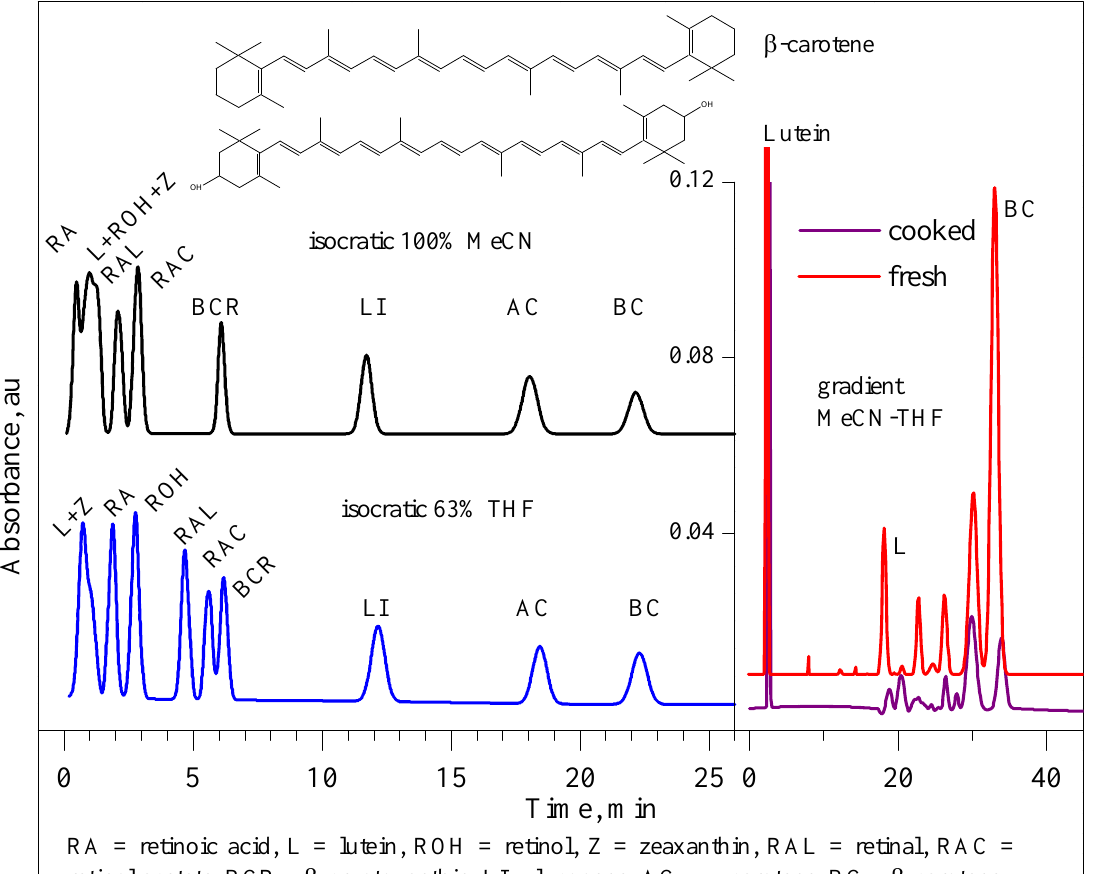
RA = retinoic acid, L = lutein, ROH = retinol, Z = zeaxanthin, RAL = retinal, RAC = retinol acetate, BCR = β -cryptoxanthin, LI = lycopene, AC = α -carotene, BC = β